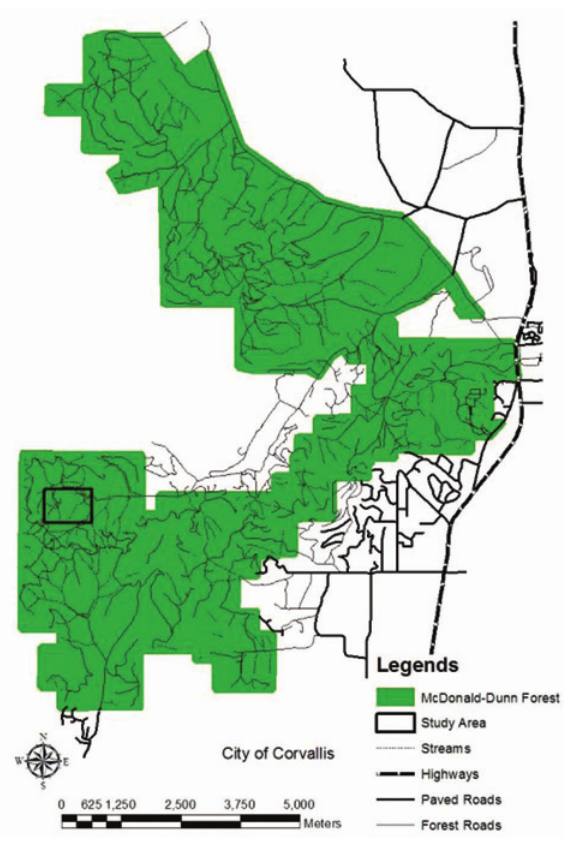
Fig. 1. McDonald-Dunn Research Forest and location of study